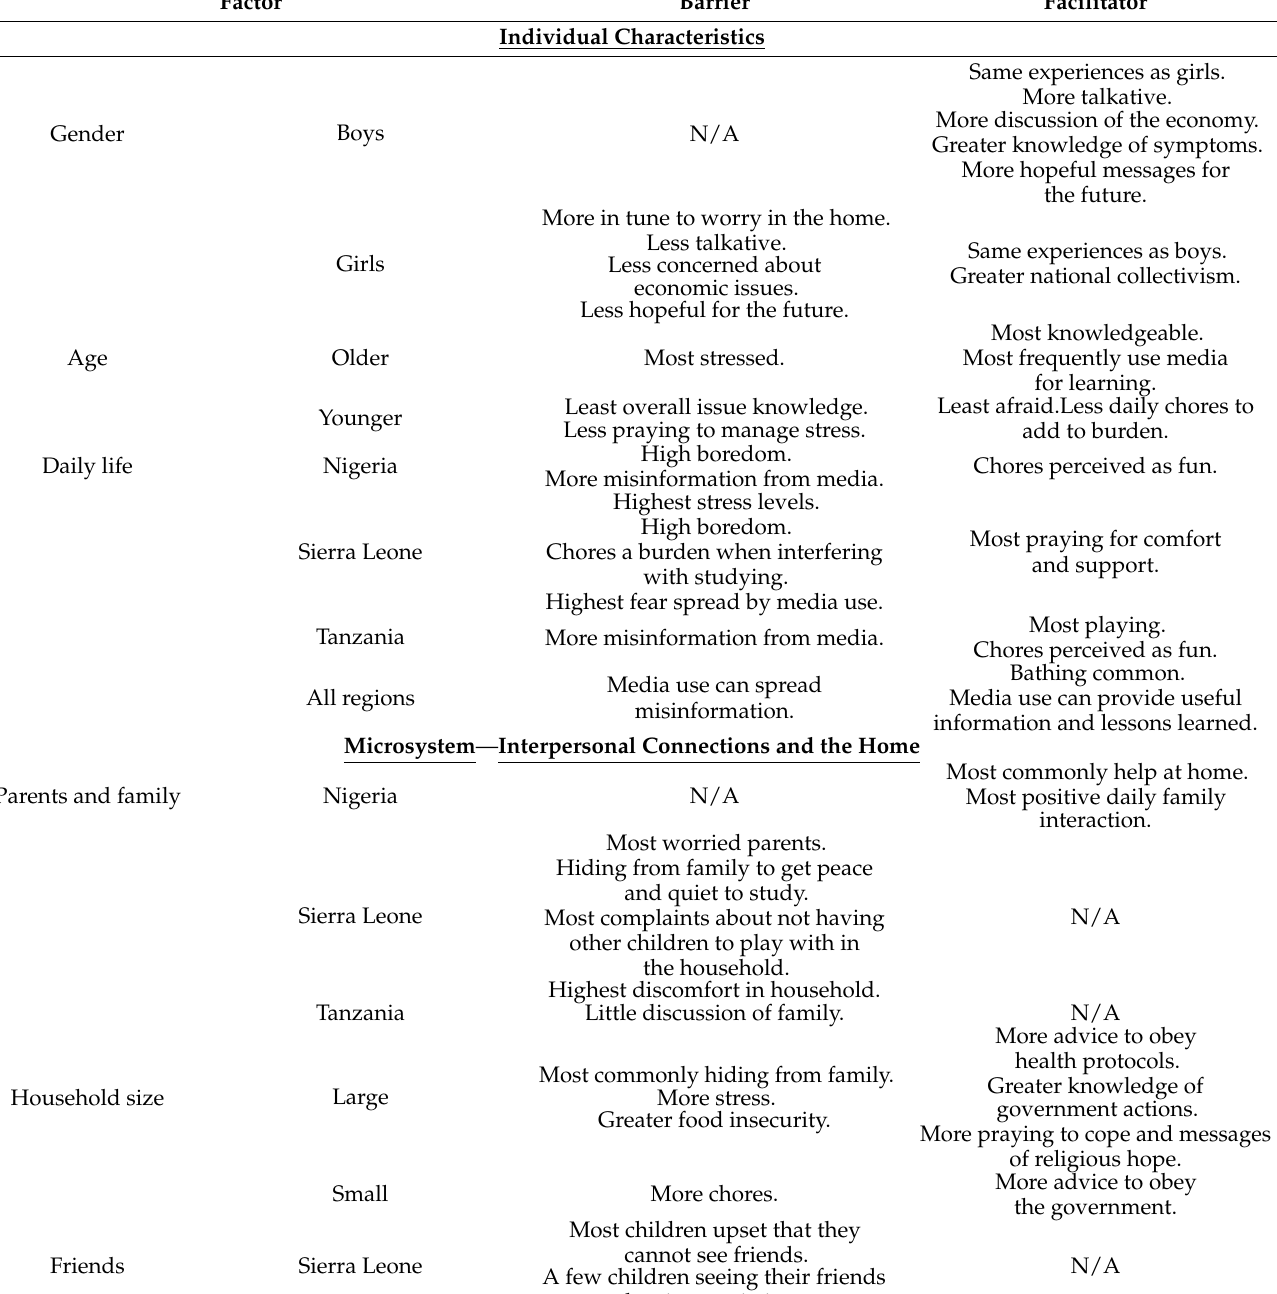
Table 2. Barriers and facilitators by level of Bronfenbrenner’s ecological systems theory, with comparisons by region and